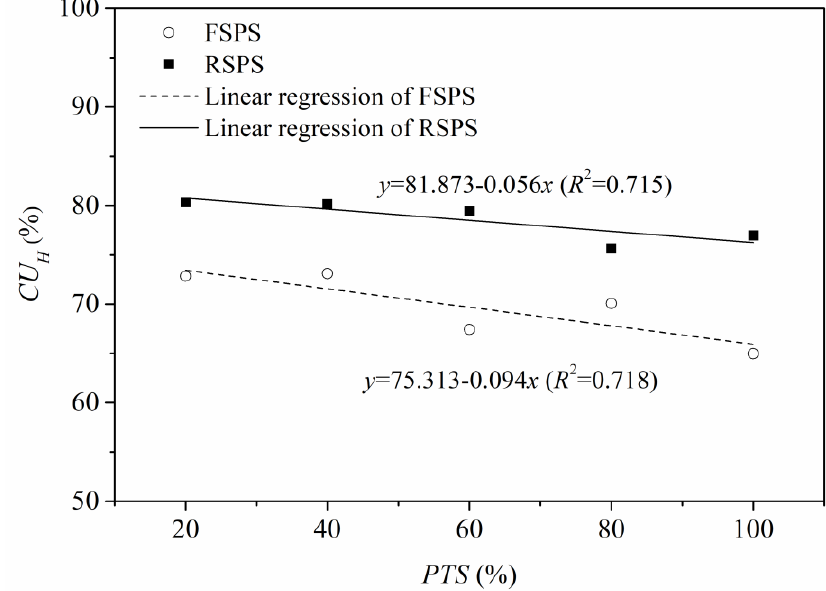
Figure 6. Relationship between water application uniformity and the travel speed in the center pivot irrigation system with FSPS and RSPS for collector I.